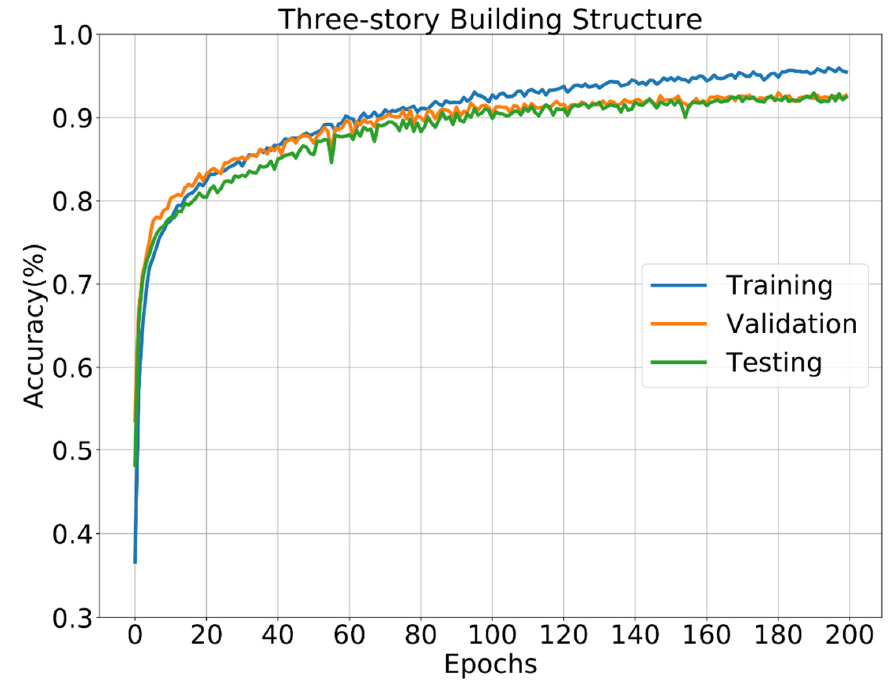
Figure 7. Training accuracy history of the FFT-DCNN algorithm.